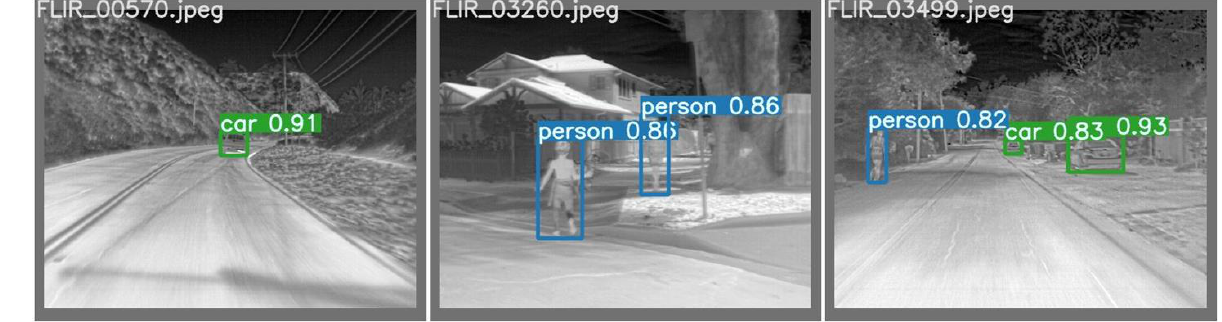
Figure 12. Visualization of the detection results obtained on the FLIR thermal dataset . Table 6. Experimental results on FLIR thermal dataset (the top three performances are highlighted in red, blue, and green, bold denotes our algorithm.).